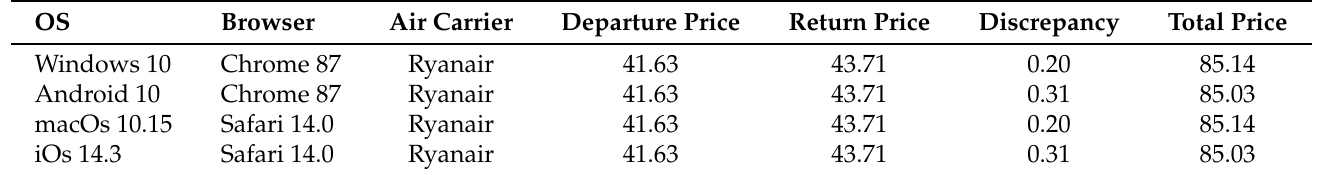
Table 6. Ryanair price